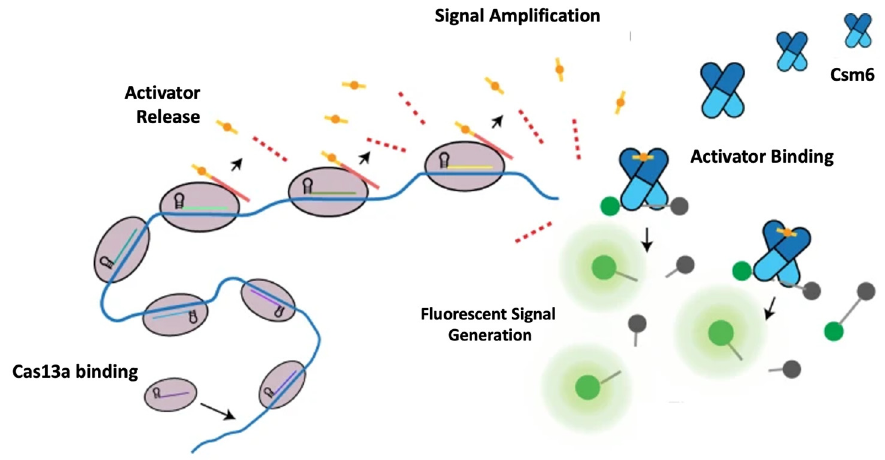
Figure 13. Schematic of FIND-IT assay. Cas13 binds to target RNA, inducing activator release. The activator then binds to Csm6, which goes on to release large amounts of flourescent molecules for detection [79].